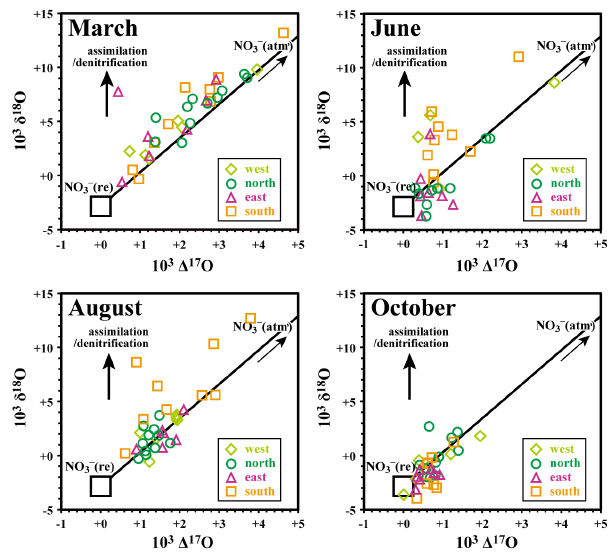
Figure 8. Temporal changes in the relationship between the val- ues of (cid:49) 17 O and δ 18 O of the total nitrate in the stream water. The symbols are the same as those in Fig. 6. A hypothetical mixing line between atmospheric nitrate (NO − (atm)) and remineralised ni- 3 trate (NO − (re)) is also shown together with the end-member value 3 of NO − (re) (large white square). The errors were smaller than the 3 sizes of the